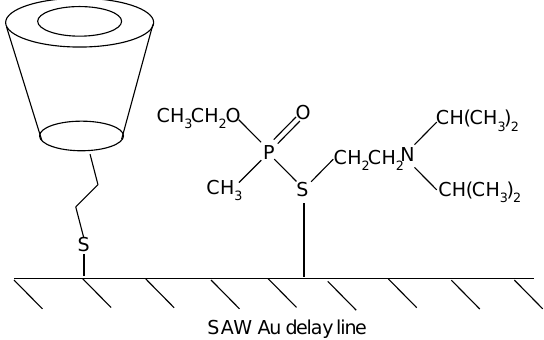
Figure 2. Competition between self-assembled film and molecular template on the surface of SAW Au delay line.